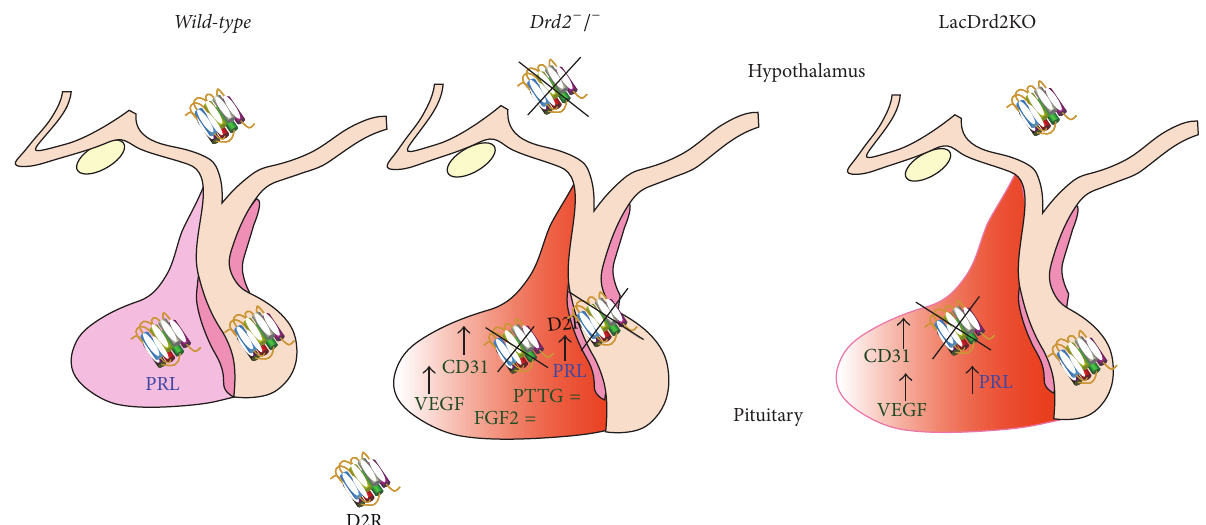
Figure 2: Total ( Drd2 −/− ) or lactotrope (LacDrd2KO) disruption of D2R evokes and increases in pituitary VEGF and CD31, with no alteration of PTTG or FGF2 content. Pituitary angiogenesis correlates with pituitary hyperplasia and increased prolactin synthesis and